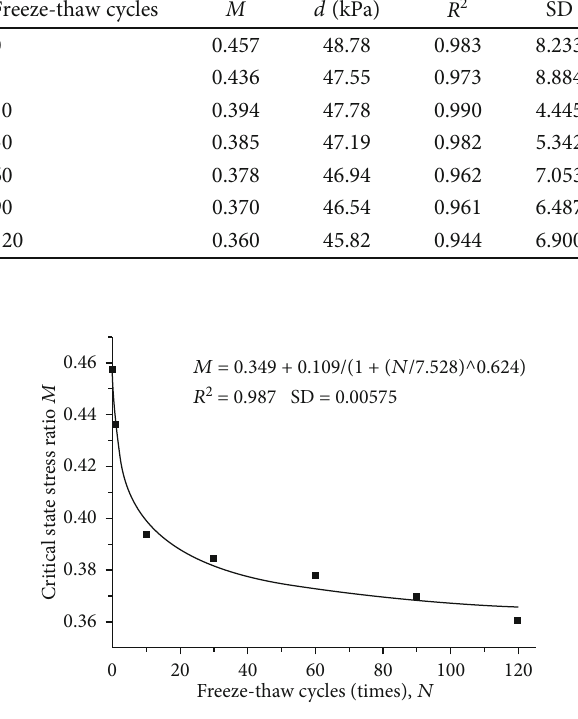
Figure 9: Change and fi tting curve of stress ratio M at a critical state.